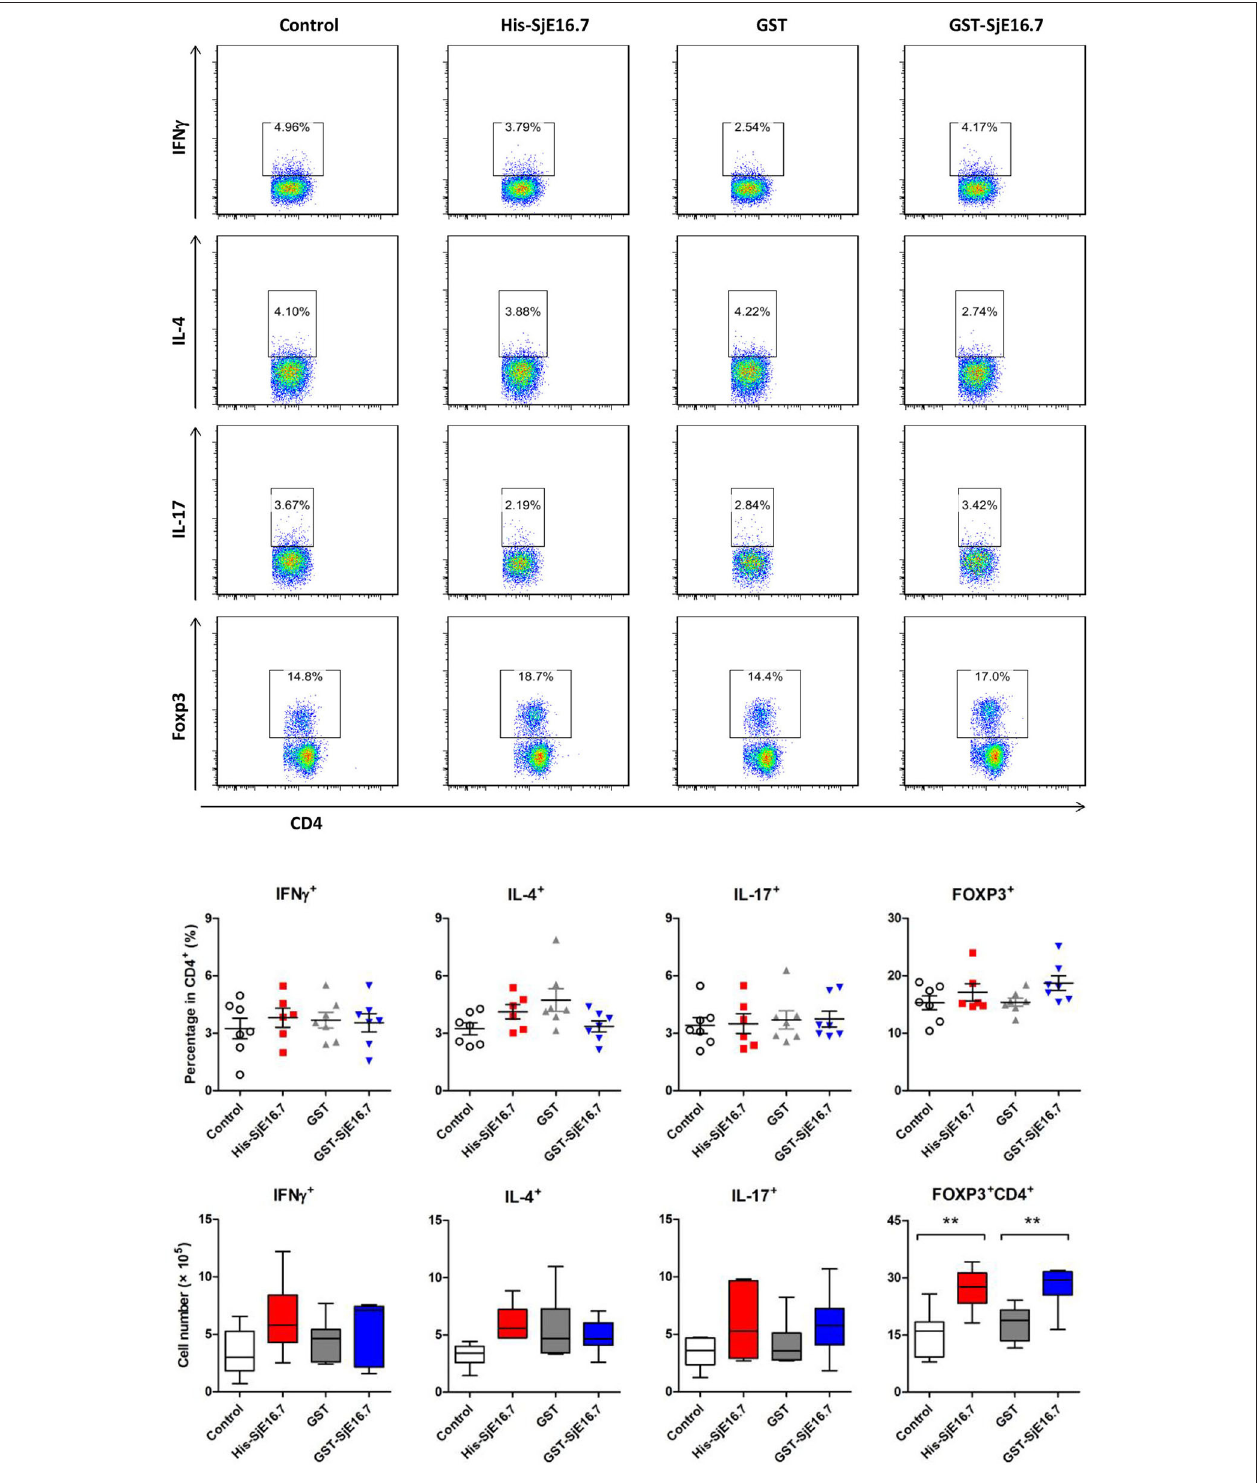
FIGURE 8 | SjE16.7 administration increases splenic FoxP3 + CD4 + T cell numbers in CAC mice treated with or without SjE16.7. Splenocytes were isolated from His-SjE16.7, GST-SjE16.7, GST-control, or PBS control treated mice 14 weeks post-CAC induction, and intracellular staining was performed as described in Materials and Methods. The frequencies of IFN- γ + , IL-4 + , IL-17 + , and Foxp3 + cells within the CD4 + population were determined by flow cytometry. The frequency and absolute number of CD4 + IFN- γ + , CD4 + IL-4 + , CD4 + IL-17 + , and CD4 + Foxp3 + cells in spleens are presented as the mean ± SEM of six to seven individual mice per group. ** p < 0.01, compared with indicated control